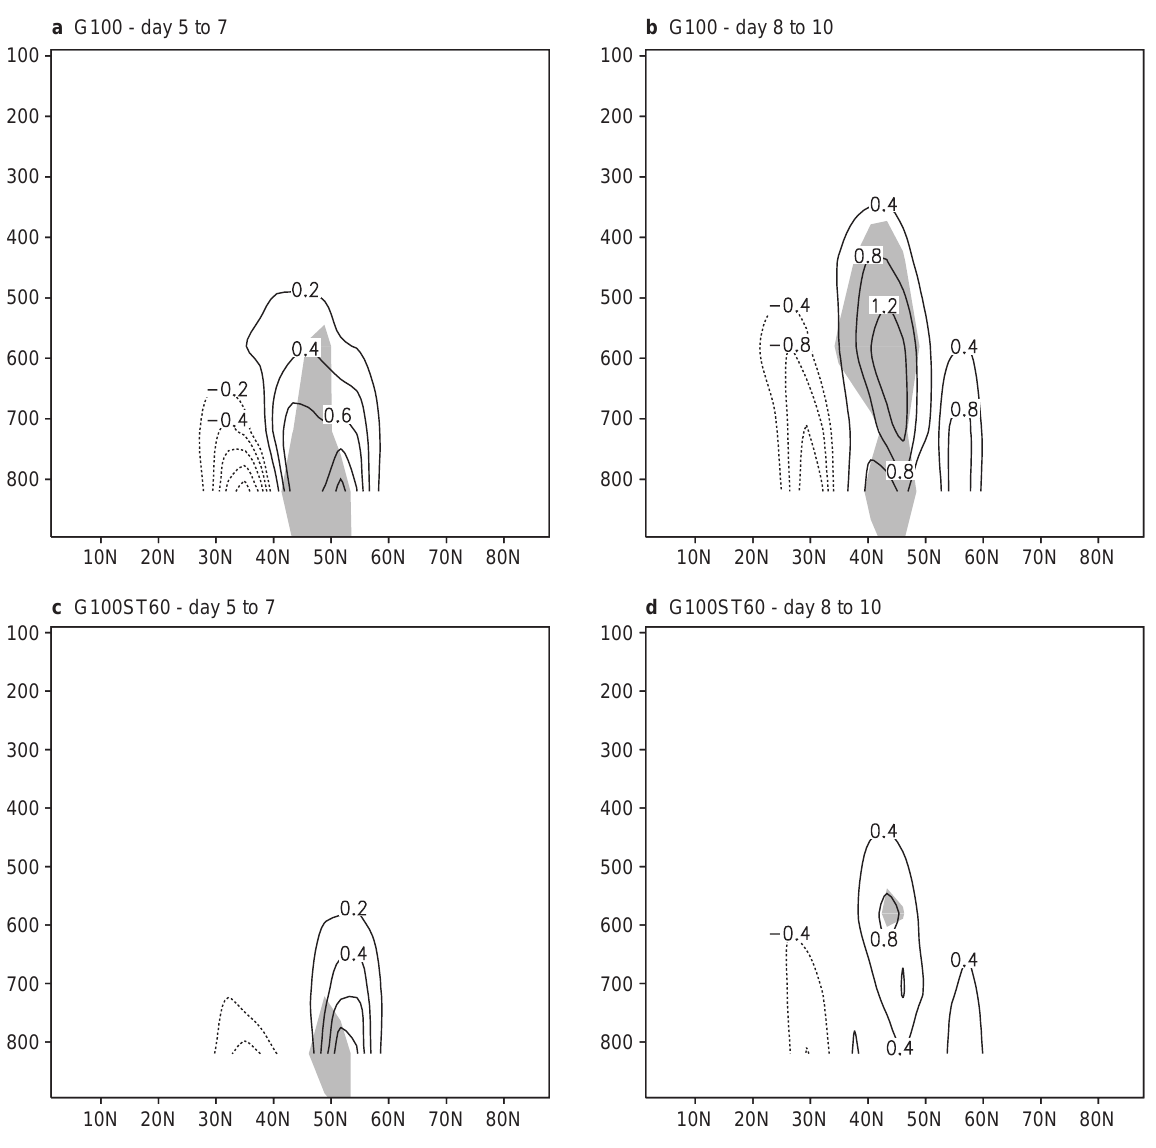
Fig. 5a–d. Zonal mean of moisture flux convergence in units of g m (cid:255) 3 per day averaged over days 5 to 7 and 8 to 10 for a, b G100 and c, d G100ST60. Contour interval is 0.2 ( a, c ) and 0.4 ( b, d ). Negative contours dashed . Zero contour omitted. Shaded areas denote